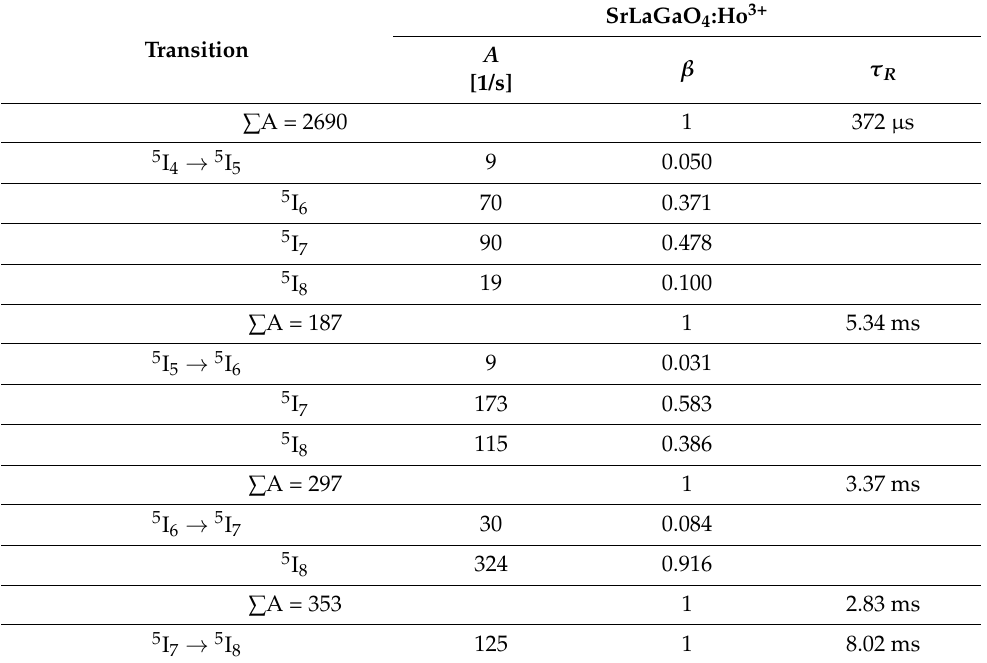
5 I 8 transition, resulting in the strongest luminescence line at about 550 nm.